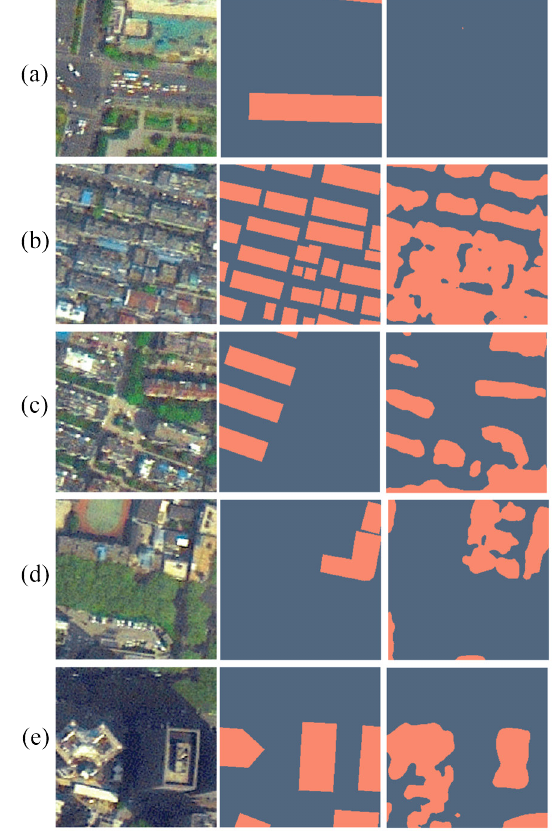
Figure 9 Comparison of building layer tiles and extracted building